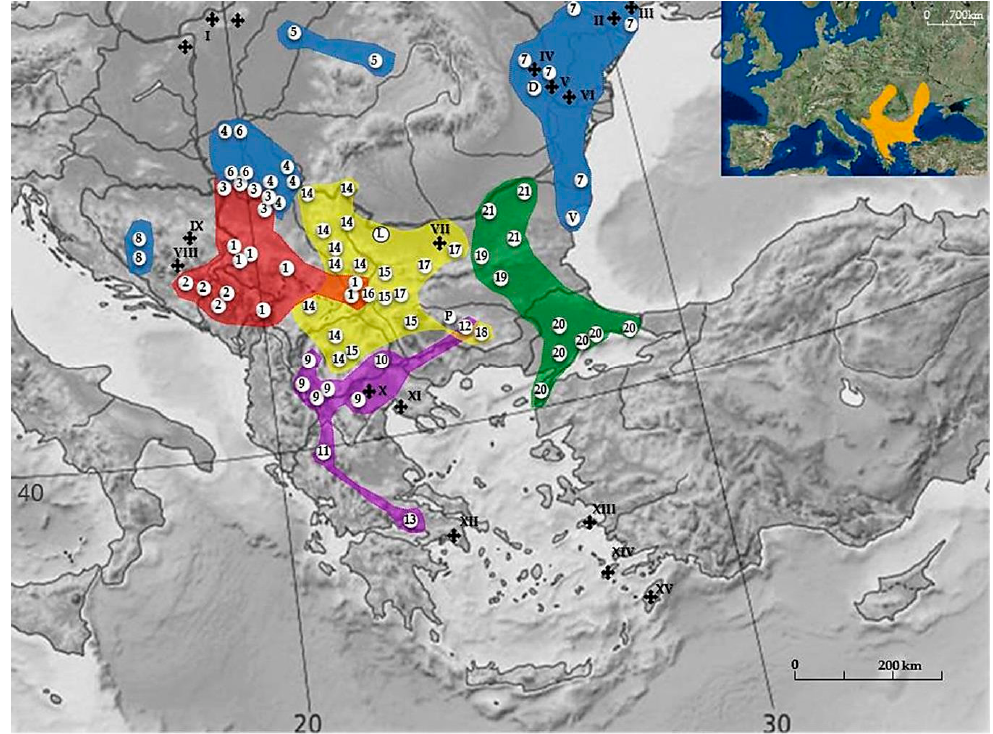
Figure 1. Geographic distribution of Nannospalax leucodon chromosomal forms (CF) from South-eastern Europe (reproduced with permission from [29], Figure 2, adapted). Red—the Yugoslav branch; yellow—the Serbicus branch; blue–the North Balkan subsidiary branch; violet–the South Balkan subsidiary branch; green—the East Balkan branch. Small map: N. leucodon distribution area from International Union for Conservation of Nature (IUCN) Red List of Threatened Species. For symbols see Table 1.